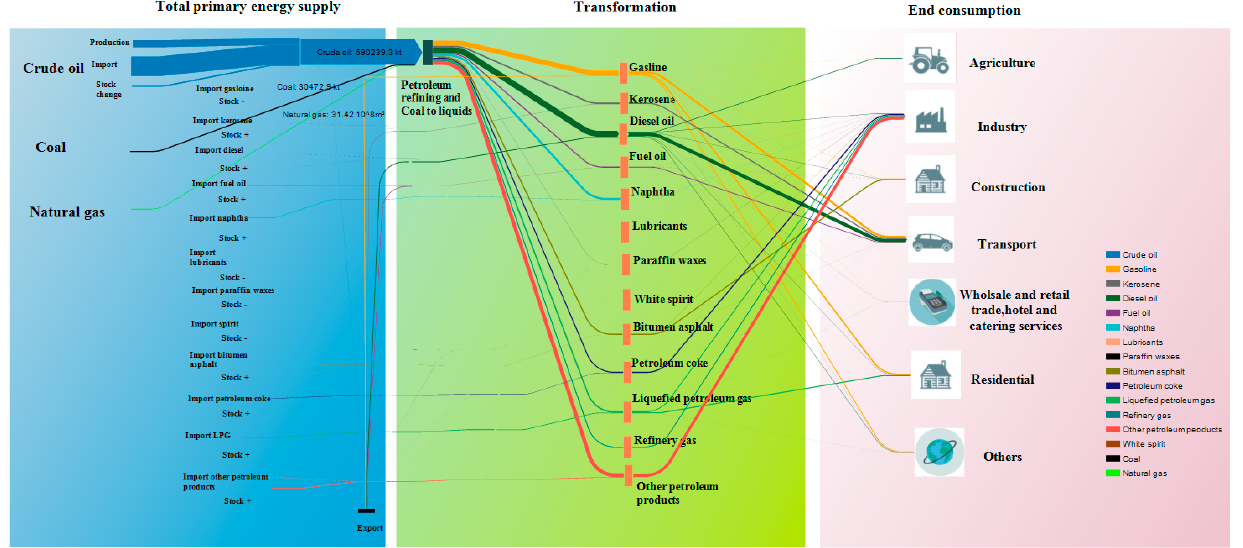
Figure 1. Panorama of petroleum production and consumption in 2020. Note: the line thickness represents the amount of quantity.